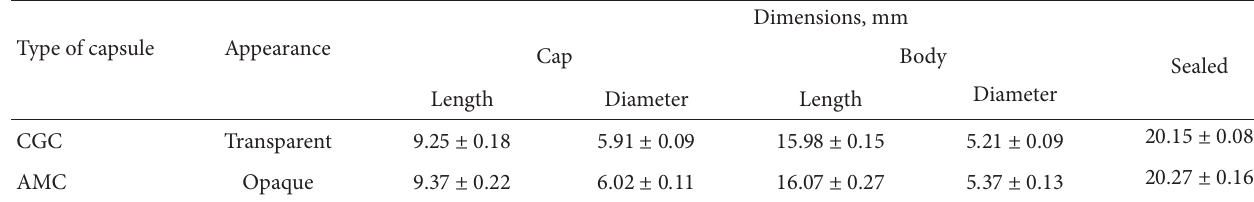
Table 3: Geometric and physical characterization of AMC ∗ as compared to CGC ∗ .